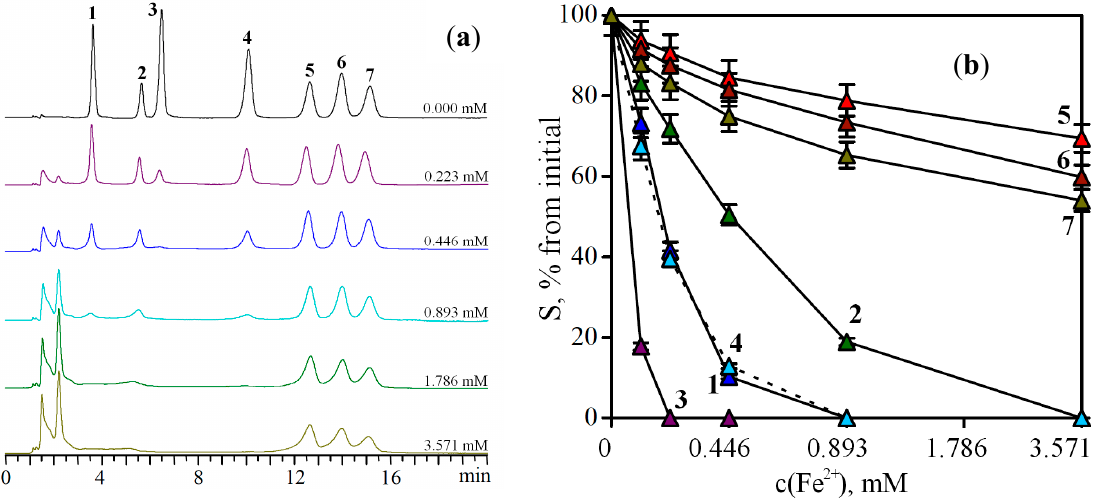
Figure 3. ( a ) Chromatograms of flavonoid mixture before (0.000 mM) and after prechromatographic reaction with Fe 2+ ions (0.223–3.571 mM). ( b ) Reduction of peak areas (S) of flavonoids in the mixture after prechromatographic reaction with different concentration of Fe 2+